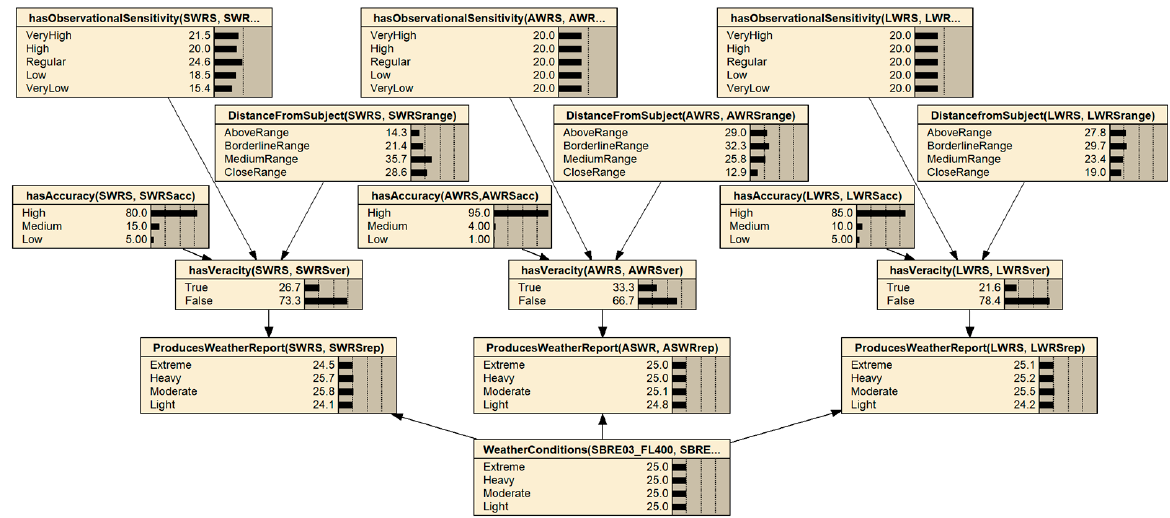
Figure 10. BN instantiated from the AAO MTheory with three sensors and two Criteria.